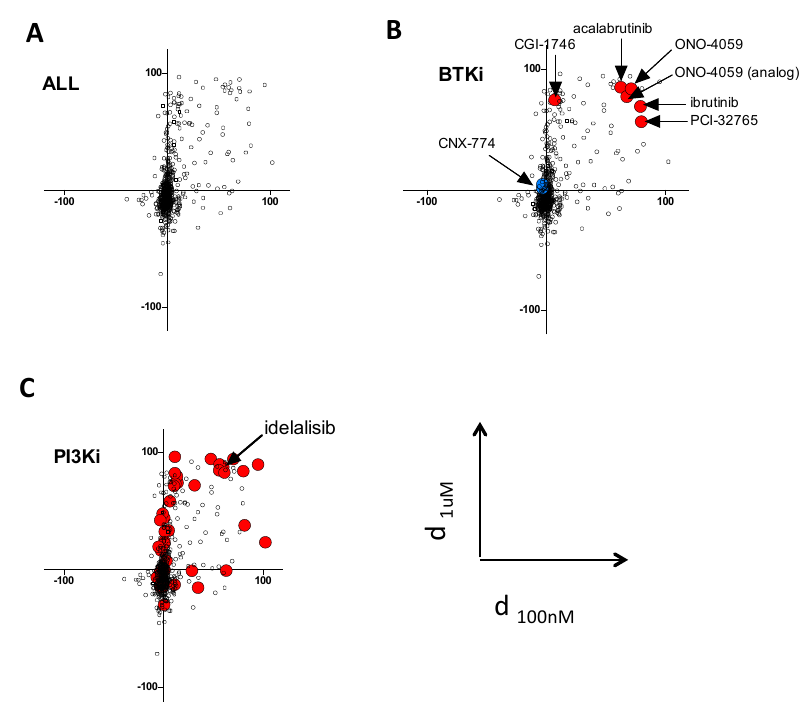
Figure 2. Collateral sensitivity screen. ( A ) The plot represents the differential effects of the compounds from the kinase inhibitors library on cellular viability in Ba/F3 cells expressing either BTK E41K or BTK E41K-C481S . Each experimental condition (mean of duplicates) is plotted according to the differential effect at 100 nM (on the X axis) and 1 µM (on the Y axis); accordingly, compounds with selective efficacy against BTK E41K fall in the right upper quadrant, and those with selective efficacy against BTK E41K-C481S fall in the lower left quadrant. ( B ) BTK inhibitors are highlighted as large colored dots. ( C ) PI3K inhibitors are highlighted as large red dots. Idelalisib, which was further studied in another cell line, is highlighted.